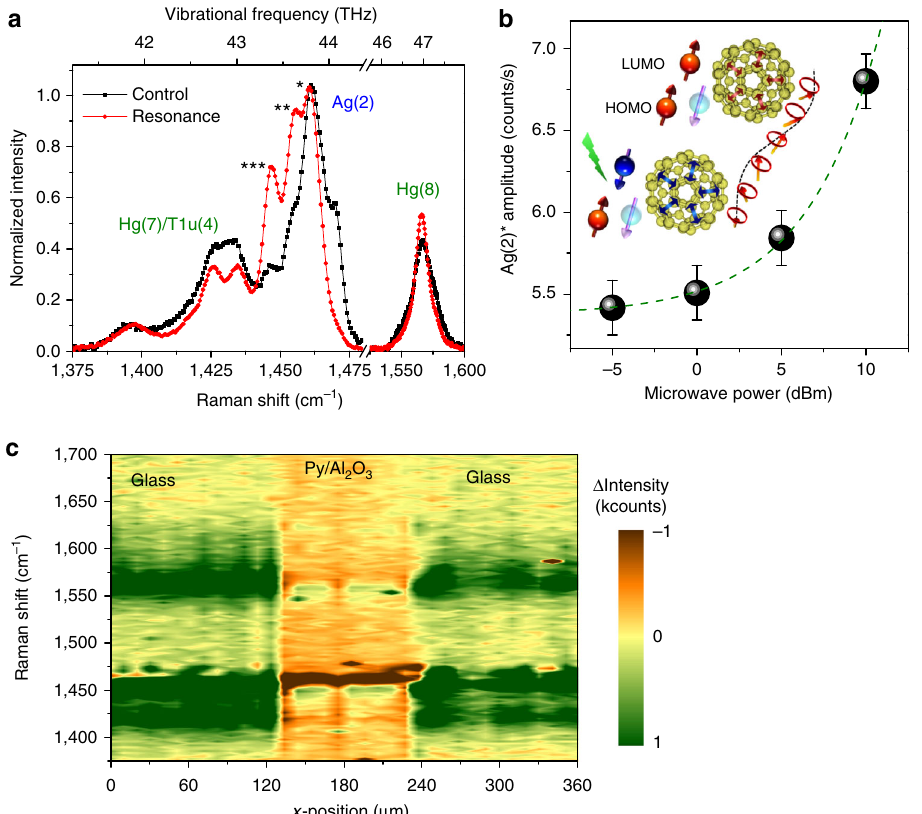
Fig. 4 Simultaneous Raman-spin pumping measurements. A 1.6 GHz resonance microwave excitation is used in a 20 Oe DC fi eld. a . Raman measurements of Glass//C 60 (10)/Py(30) comparing the off (control) and on resonance states of C 60 on Py. The main Ag(2) peak at 1,467 cm − 1 splits and shifts to lower frequencies attributed to the formation of triplets and enhanced Coulomb interactions. The splitting in the Hg(7) peak may be due to changes in the molecular symmetry. An in-depth analysis is shown in Fig. S.2. b . Amplitude of the Ag(2)* duplicate at different microwave powers. This mode is associated with high spin and charged states promoted by the spin current; schematic as inset (arrows show the atomic movement in the Ag(2) mode). Error bars represent the maximum fl uctuation observed in the Raman Ag(2) peak amplitude, and the fi t (dashed line) is proportional to the power in Watts. c . Change in Raman intensity for maps on/off resonance as a function of wavenumber and position for C 60 with a 100 μ m wide Al 2 O 3 (2)/Py(30) track on top. The Ag and Hg modes for C 60 under the track are red-shifted during